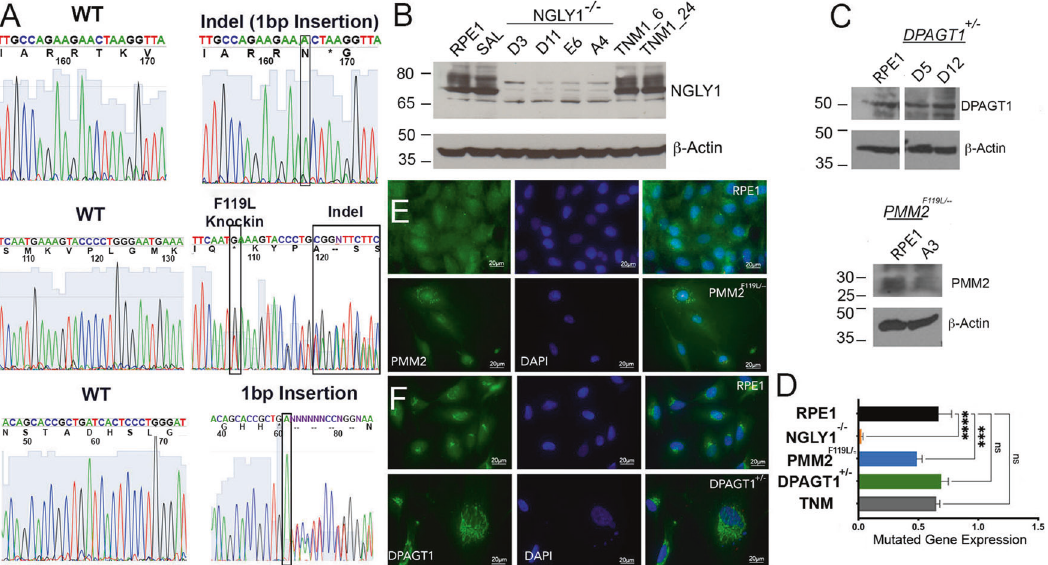
Fig. 1 CDG and CDDG cellular models were validated by Sanger sequencing, immunoblot and immuno fl uorescence staining for target proteins. A Electropherogram traces for parental RPE-1 cells, CDDG — NGLY1 − / − D11 (top), and CDG — PMM2 F119L/ − A3 (middle) and DPAGT1 + / − D5 (bottom) lines. B , C Representative immunoblot images for target proteins in RPE-1 and isogenic CDDG ( B ) and CDG ( C ) lines. RPE-1 cells treated with TNM (1µM for either 6h or 24h) were used as a positive control. D Quanti fi cation of the target protein levels in the edited RPE-1 cells ( n ≥ 3 per genotype). Expression relative to levels in parental RPE-1 cells. *** P <0.001, **** P <0.0001, one-way ANOVA followed by Dunnett multiple comparisons post-test. E , F Representative immuno fl uorescence images for staining for PMM2 and DPAGT1 in parental RPE-1, CDG — PMM2 F119L/ − A3, and CDG DPAGT1 + / − D5 lines. Scale bar: